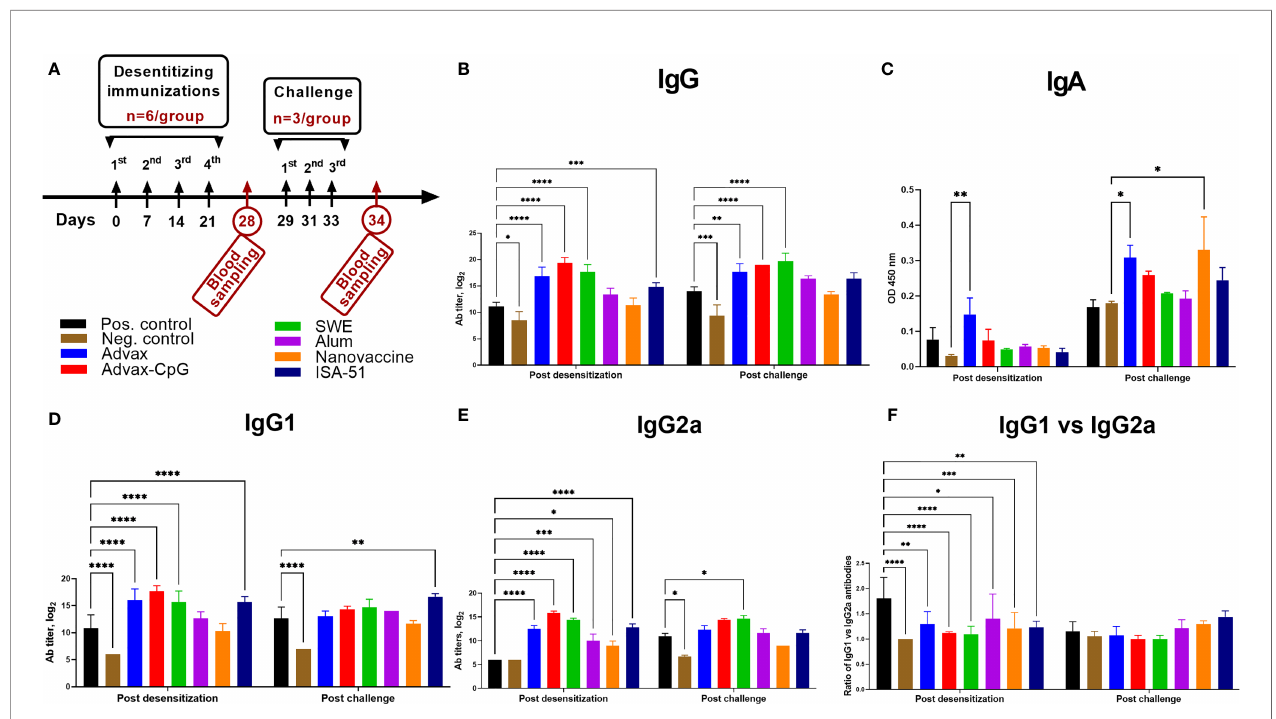
FIGURE 3 | Art v 1-speci fi c serum IgG (B) , IgG1 (D) , IgG2a I (E) , IgA (C) , and IgG1 to IgG2a ratio (F) in BALB/cmiceafter ASIT andchallenge. ASIT was performed with Art v 1 proteinformulated with Advax, Advax-CpG, SWE, aluminum hydroxide, or ISA-51 (A , study design). A group of mice that received intranasalArt v 1 protein-loaded mannose-chitosan nanoparticleASIT was included for comparison. Challenge of animals was performed by intranasal injection and inhalation of wormwoodpollen extract. Antibody levels are presentedas geometric mean titerswith 95% con fi dence intervals and expressed inlog 2 . Differences in antibody levels between groups were assessed usingS ̌ ı ́ da ́ k ’ s multiplecomparisons test. A P < 0.05 value was considered signi fi cant. *P < 0.05, **P < 0.01, ***P < 0.001, and ****P <